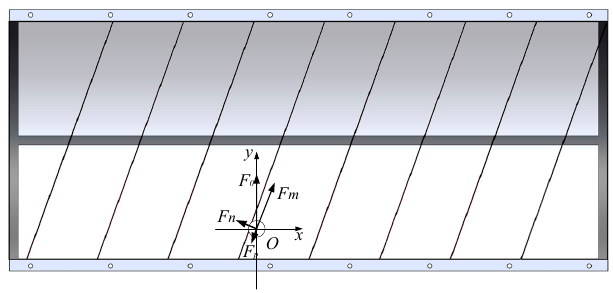
Figure 6. Force analysis of guided spiral material.